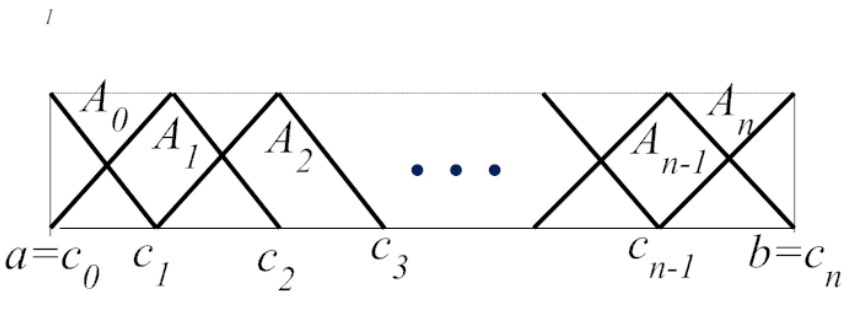
Figure 1. A typical h -uniform triangular fuzzy